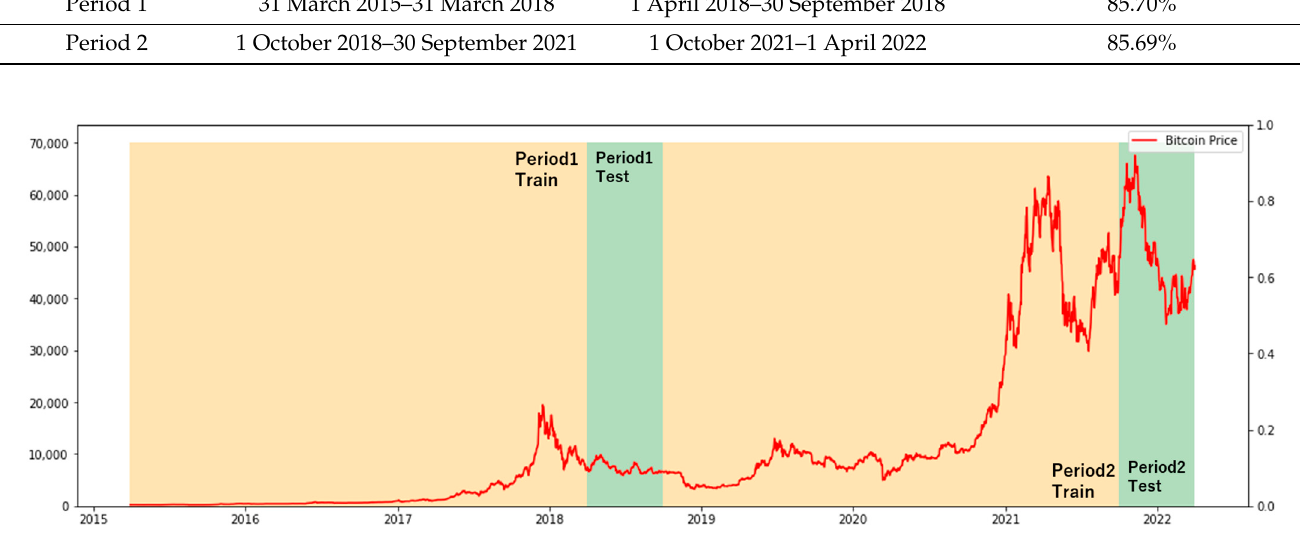
Figure 6. Interval division of training samples and test samples.